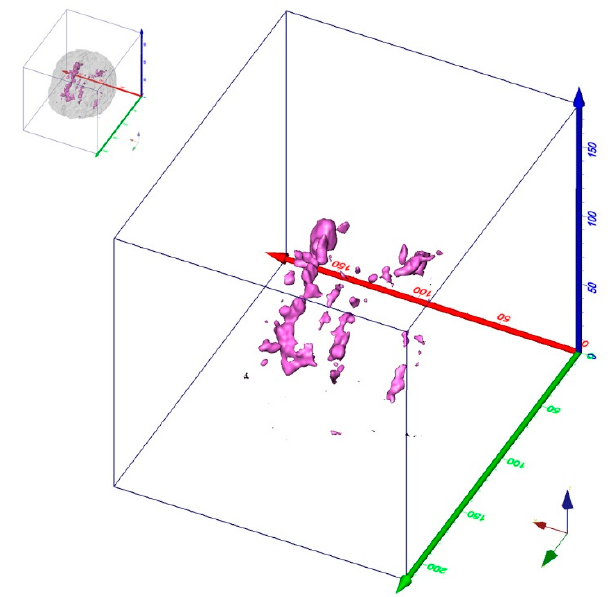
Figure 1. 3D-view of binary MS-lesion mask in MNB geometry (phantom of human brain with severe MS lesions, binarized (threshold value = 0.5). MS-lesions (with voxel value of 1) are magenta, all other volume (with voxel value of 0) is transparent. Small insert top left indicates position of MS-lesions within white matter (transparent grey). Axis colors: x = red, y = green, z = blue. Axis scale: millimeters.